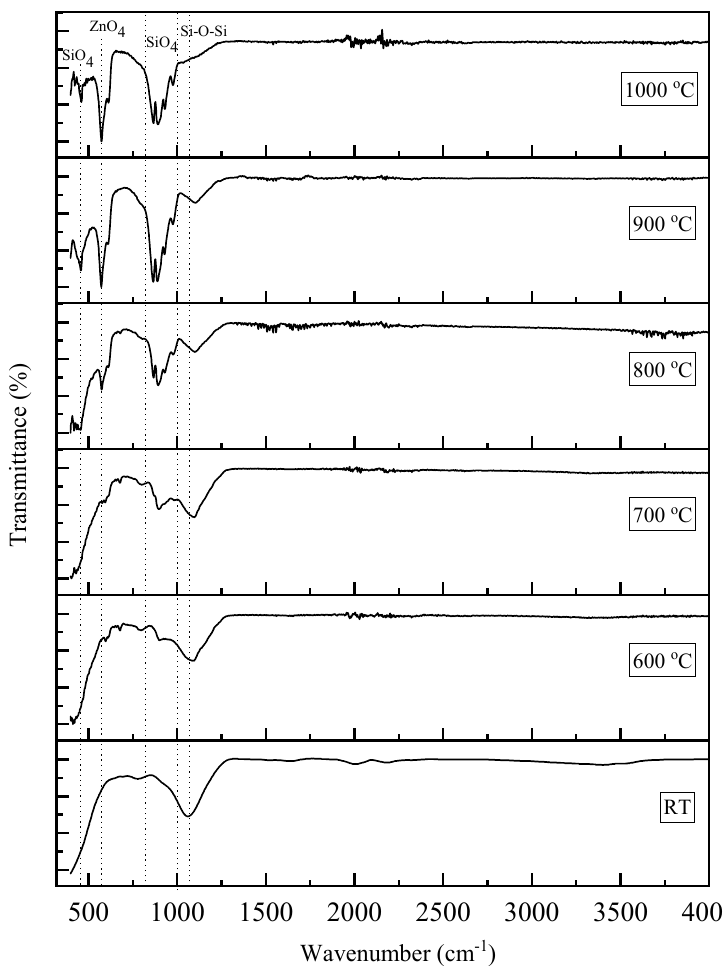
ff erent sintering